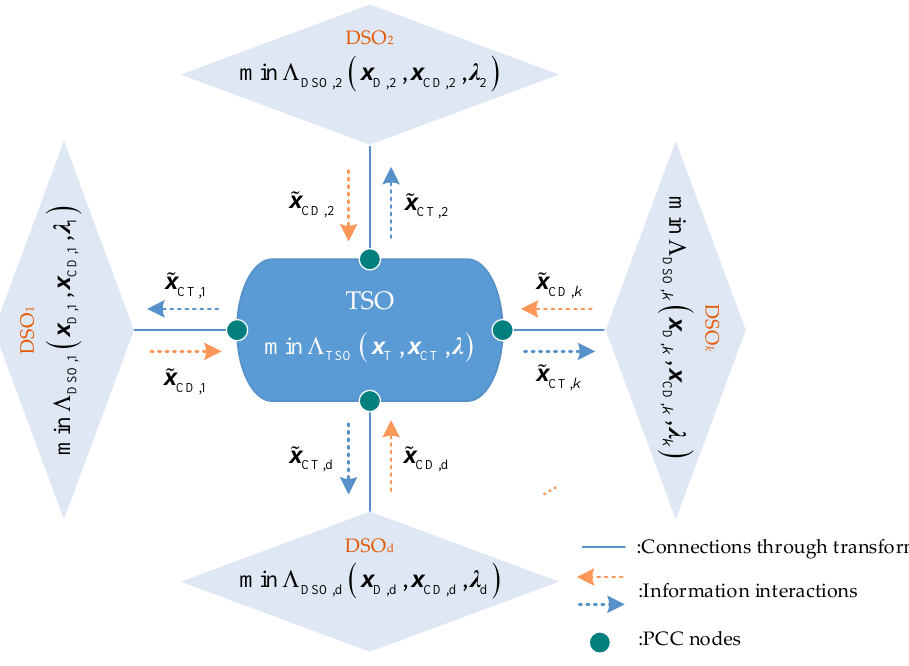
Figure 3. Interactions between TSO and DSOs in the proposed distributed framework. In each iteration, the transmission network subproblem is solved first, and then the coordinating variables are transferred to each distribution network subproblem. After the distribution network receives the coordinating variables, the subproblems are solved in parallel, and then the updated coordinating variables are transmitted to the transmission network. After the transmission grid receives data from all distribution grids, feasibility constraints and optimality constraints are checked. The optimal solution is obtained, and the optimization process ends if these two constraints are satisfied. Otherwise, the next iteration begins. Due to the parallelism of the subproblems, the time consumed by each iteration process depends on the transmission network optimization time and the distribution network with the longest optimization time. The detailed iterative steps of the algorithm are as follows.